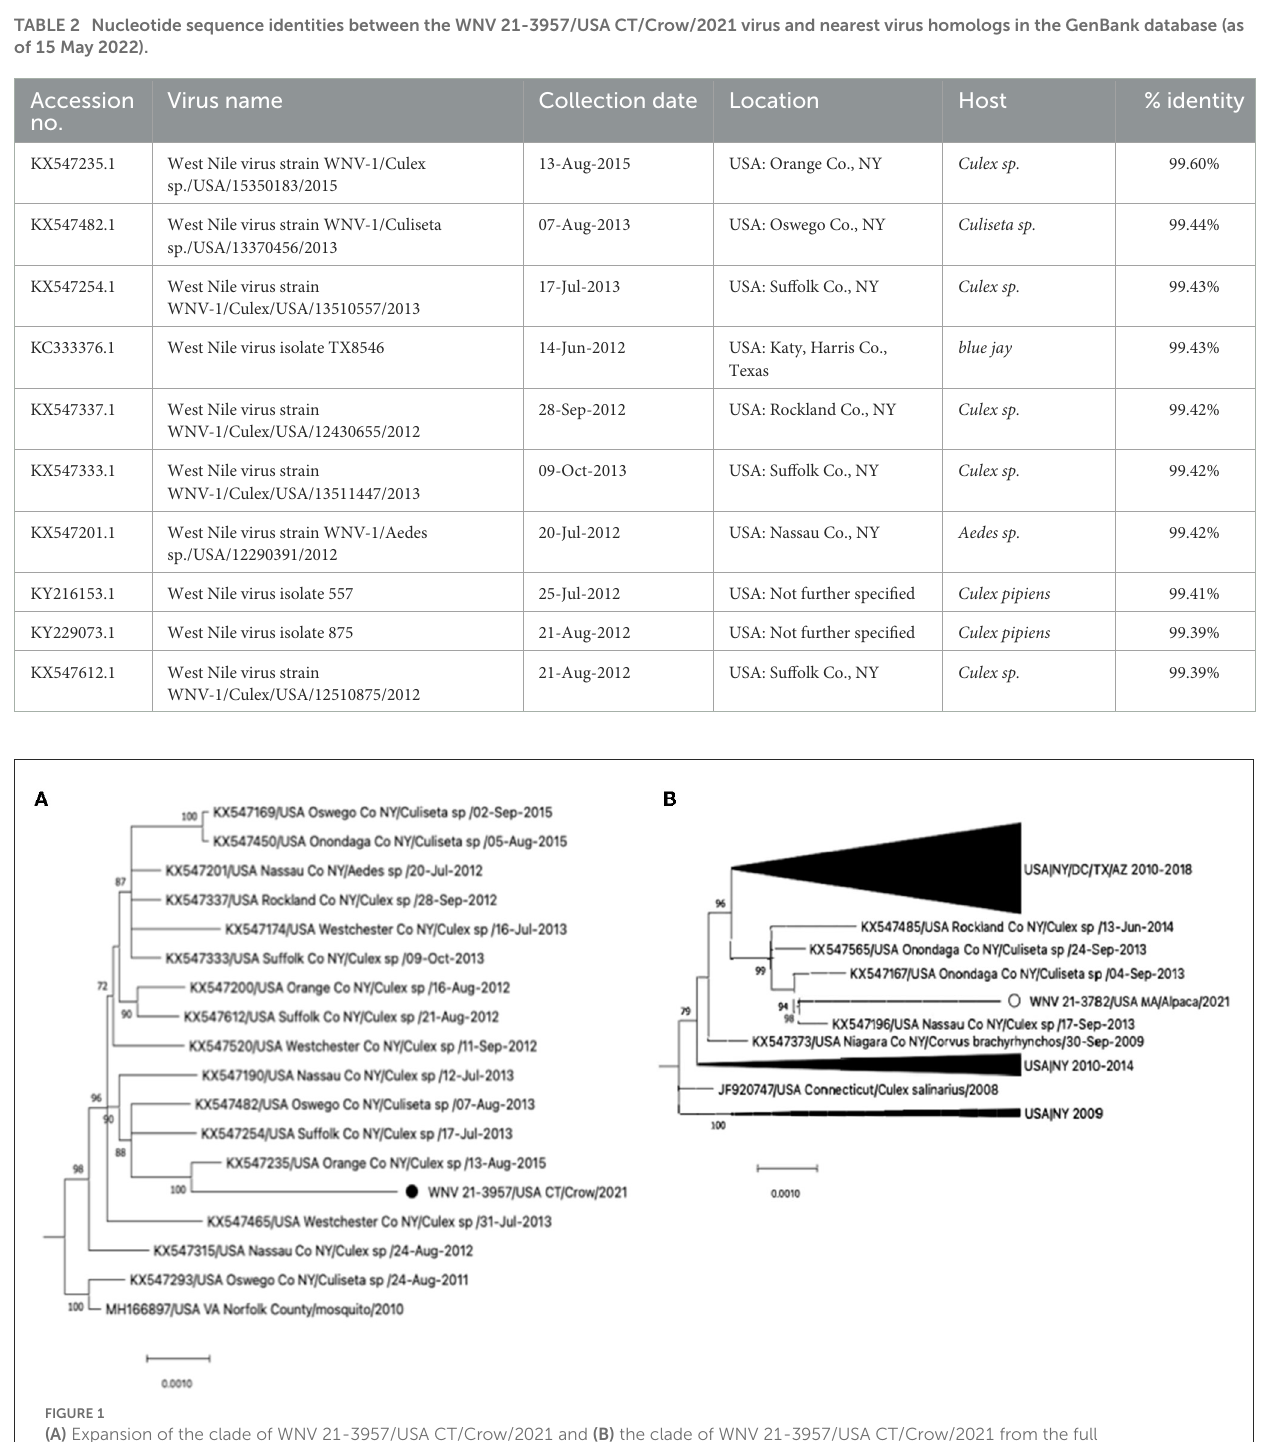
North America at an estimated evolutionary rate of 4.59 × 10 − 4 substitutions/site/year (data not shown). However, the details of the transmission routes of these viruses remain uncertain due to the lack of recent genome sequences and surveillance